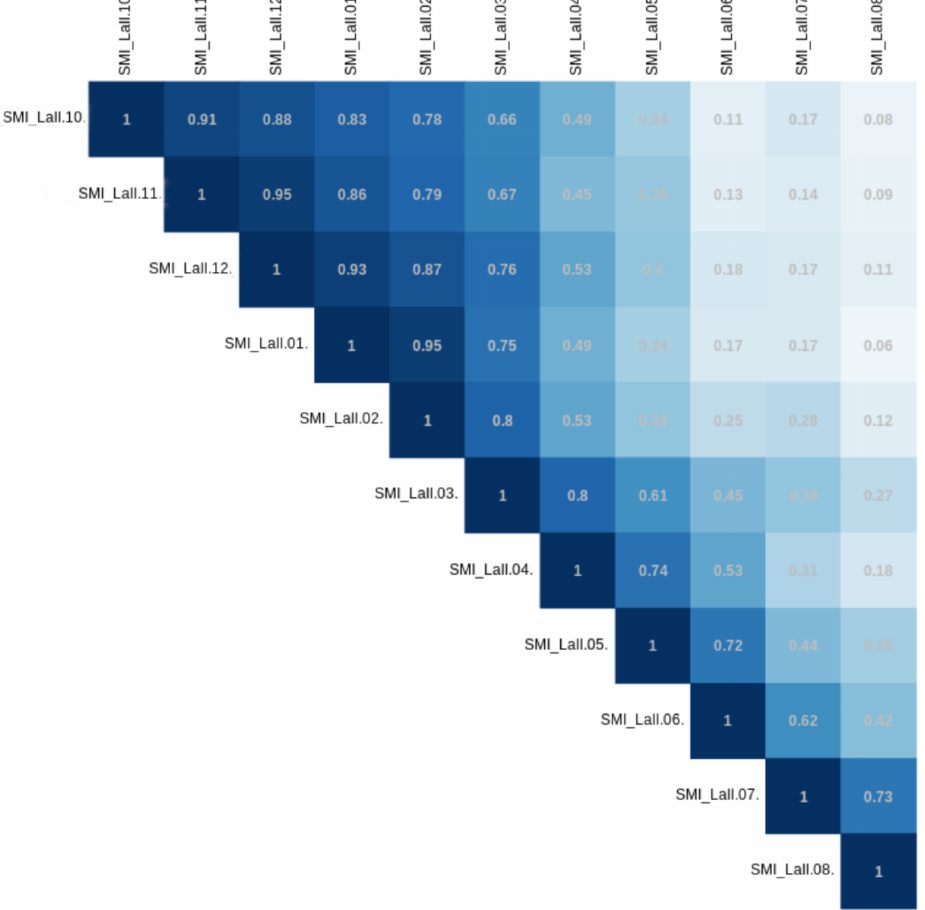
Germany from October to August. This correlation